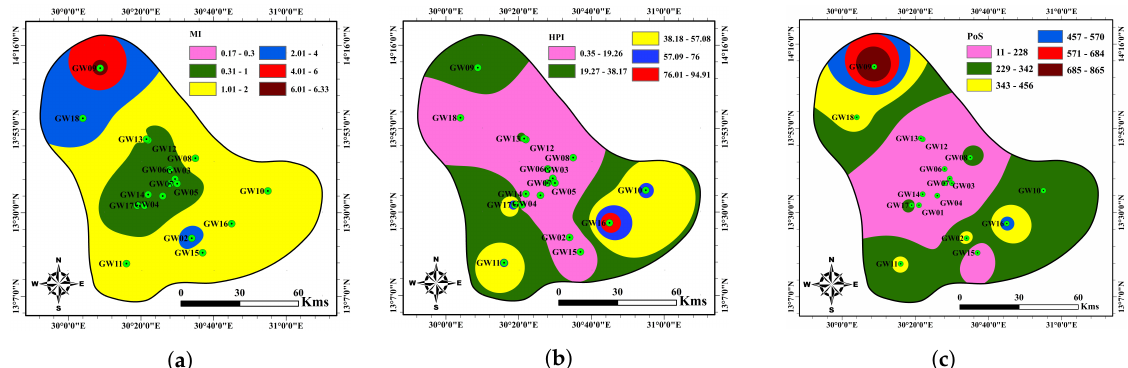
Figure 4. Spatial distribution of groundwater samples and GIS interpolation maps of ( a ) MI, ( b ) HPI and ( c ) PoS values in the study